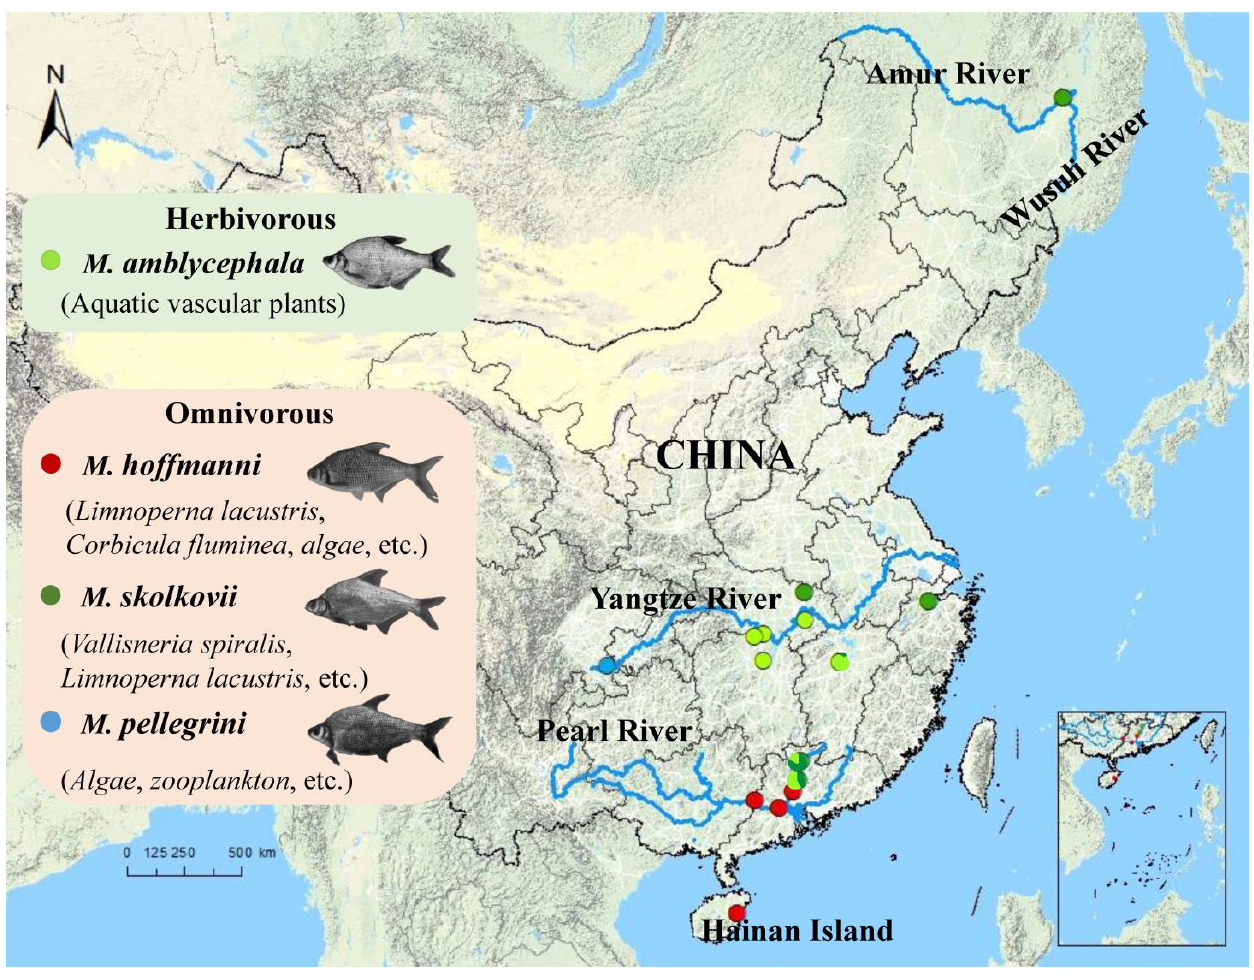
Figure 1. Geographic map indicating the distribution and feeding habits of the Megalobrama species in this study. Circles reflect the geographic regions where the samples were collected from. The blue lines represent the rivers.